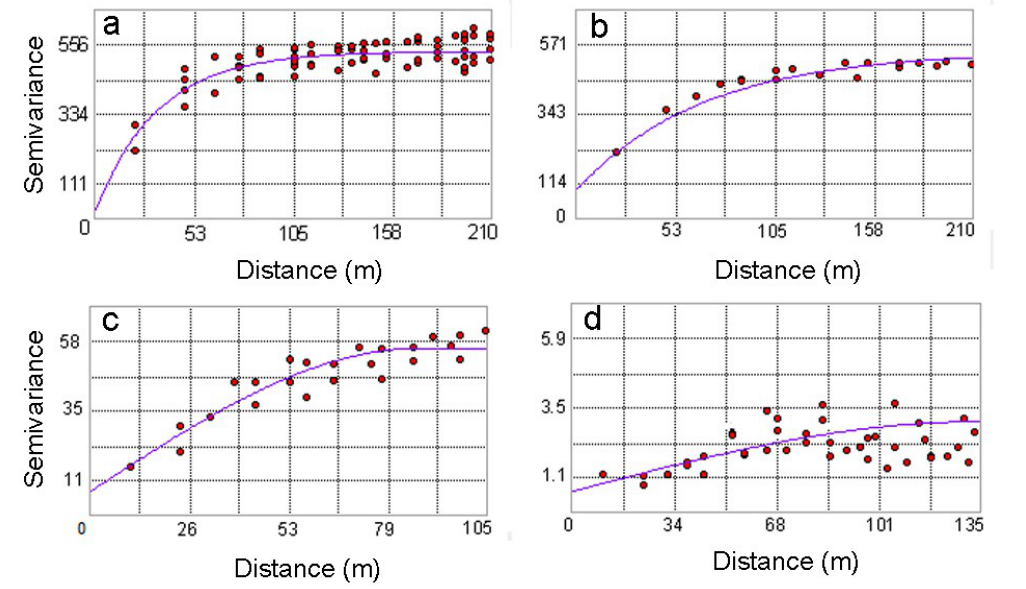
Figure 16. Semivariograms constructed from PC1 for three of the surface types in Figure 4: ( a ) semivariogram for debris-covered ice with no search direction; ( b ) semivariogram for debris-covered ice with search direction; ( c ) bare rock/sand outside the glaciers and ( d ) ice/snow in the accumulation area of